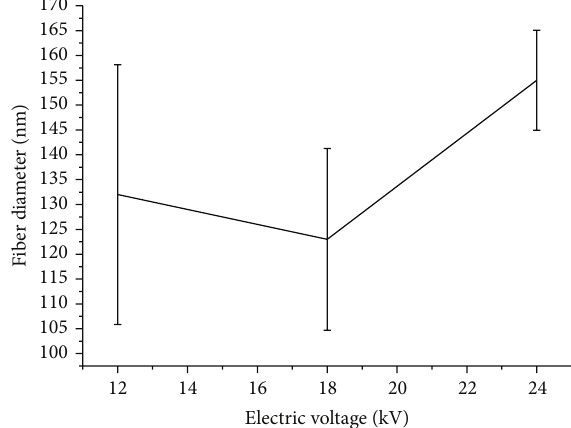
Figure 4: Average diameters of NaAlg/PEO nanofibers at different